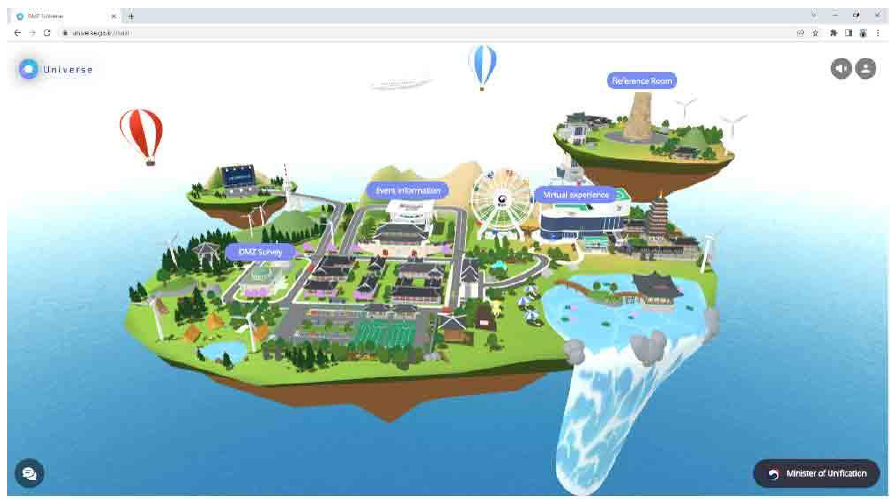
Figure 9. Landing Page for virtual space